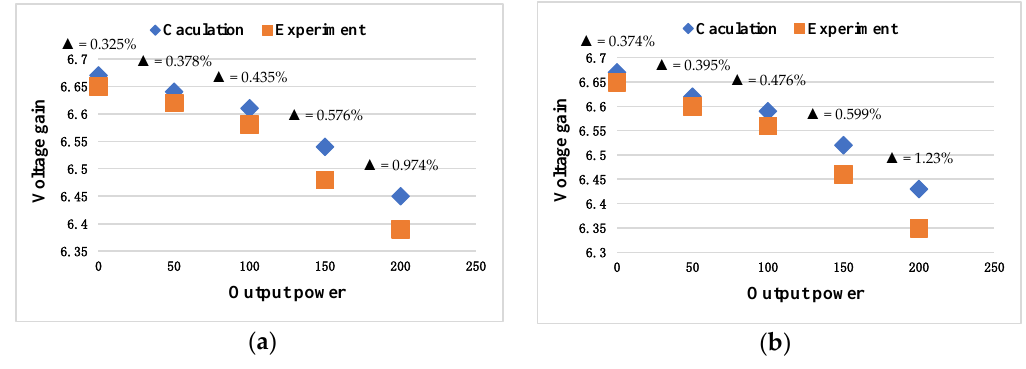
Figure 18. Experimental and calculated voltage gain under different cases. ( a ) Condition 1. ( b ) Condition 2.